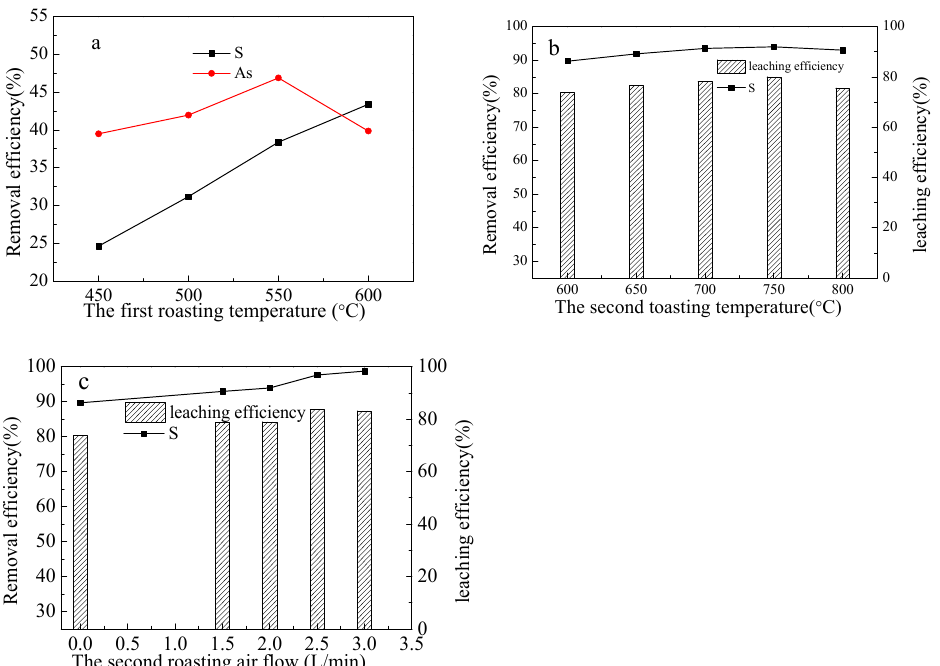
Figure 6. Effects of the first roasting temperature ( a ), the second roasting temperature ( b ) and air flow rate of second stage roasting ( c ) on the removal efficiency of As and S, and leaching efficiency of gold in the two stage roasting.